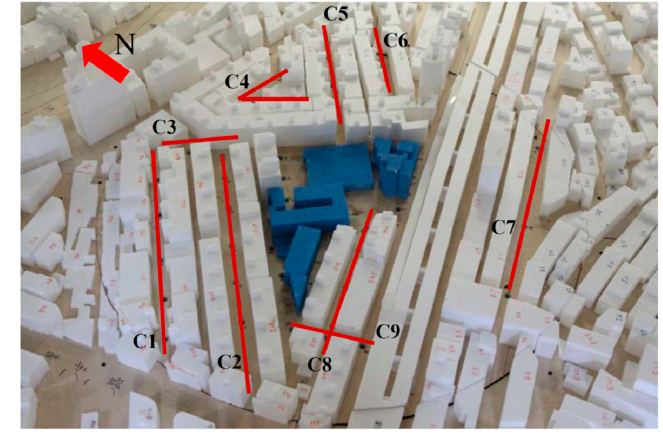
Figure 2. Placement of Irwin probes within street canyons C1–C9.